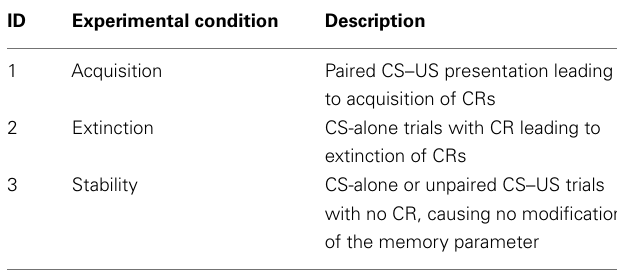
Table 1 | Stimulation conditions for the closed-loop experiment